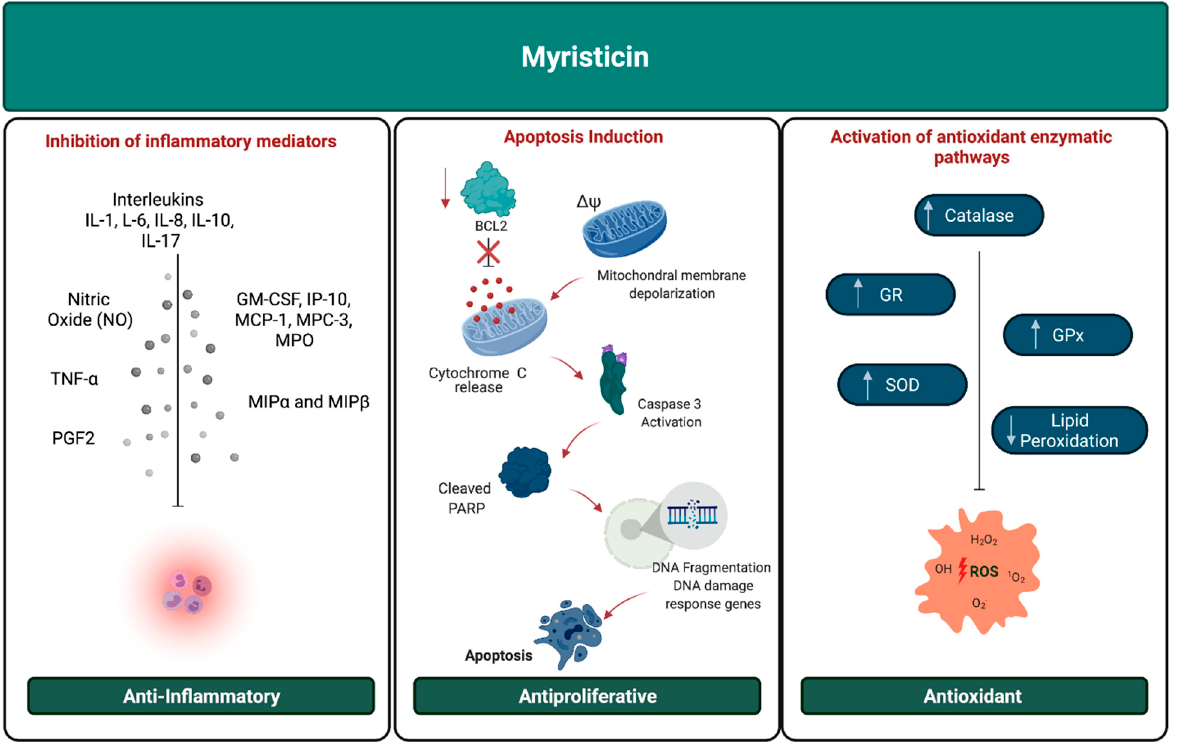
Figure 2. Graphical representation of the anti-inflammatory, antiproliferative and antioxidant pathway mechanisms induced by myristicin.